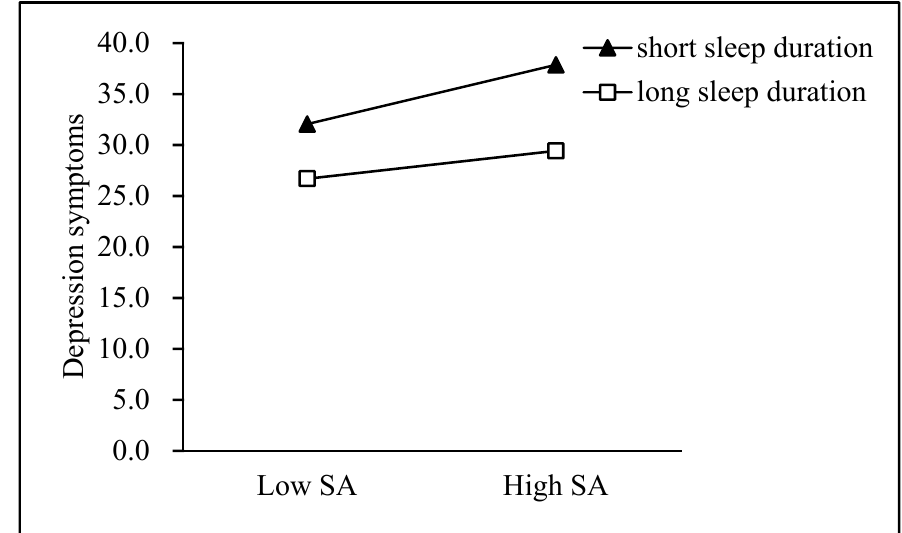
Figure 4. Sleep duration moderates the effect of social anxiety on depressive symptoms. SA = Social anxiety